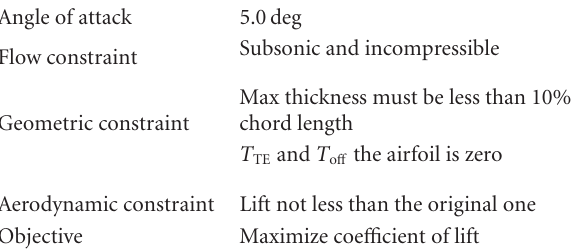
Table 1: Optimization objectives and